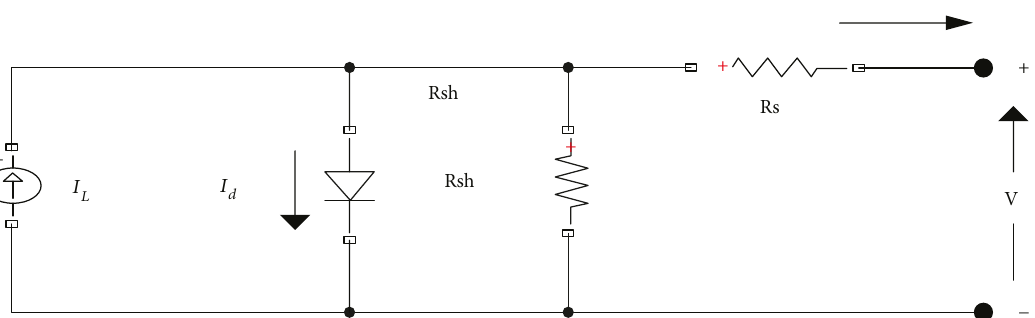
Figure 9: Diode model of a PV module.